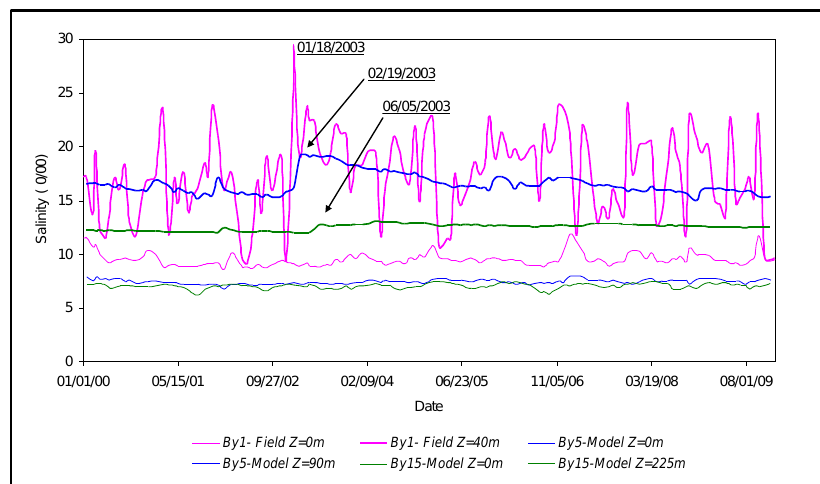
Figure 20. Time series of surface and bottom salinities at stations BY1, BY5, and BY15.